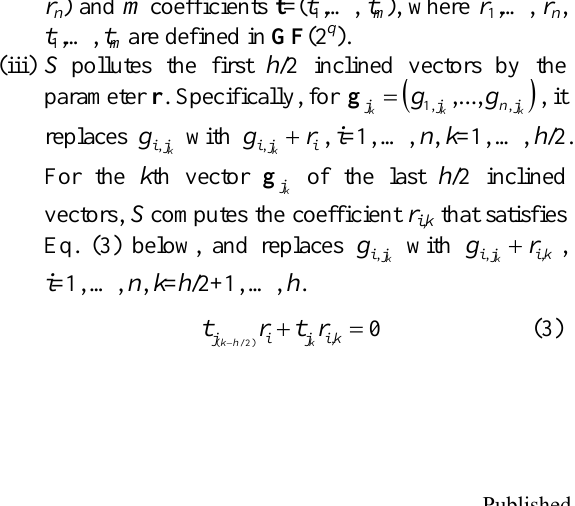
Fig. 3. An example about the scheme PSSP ( n =4 and m